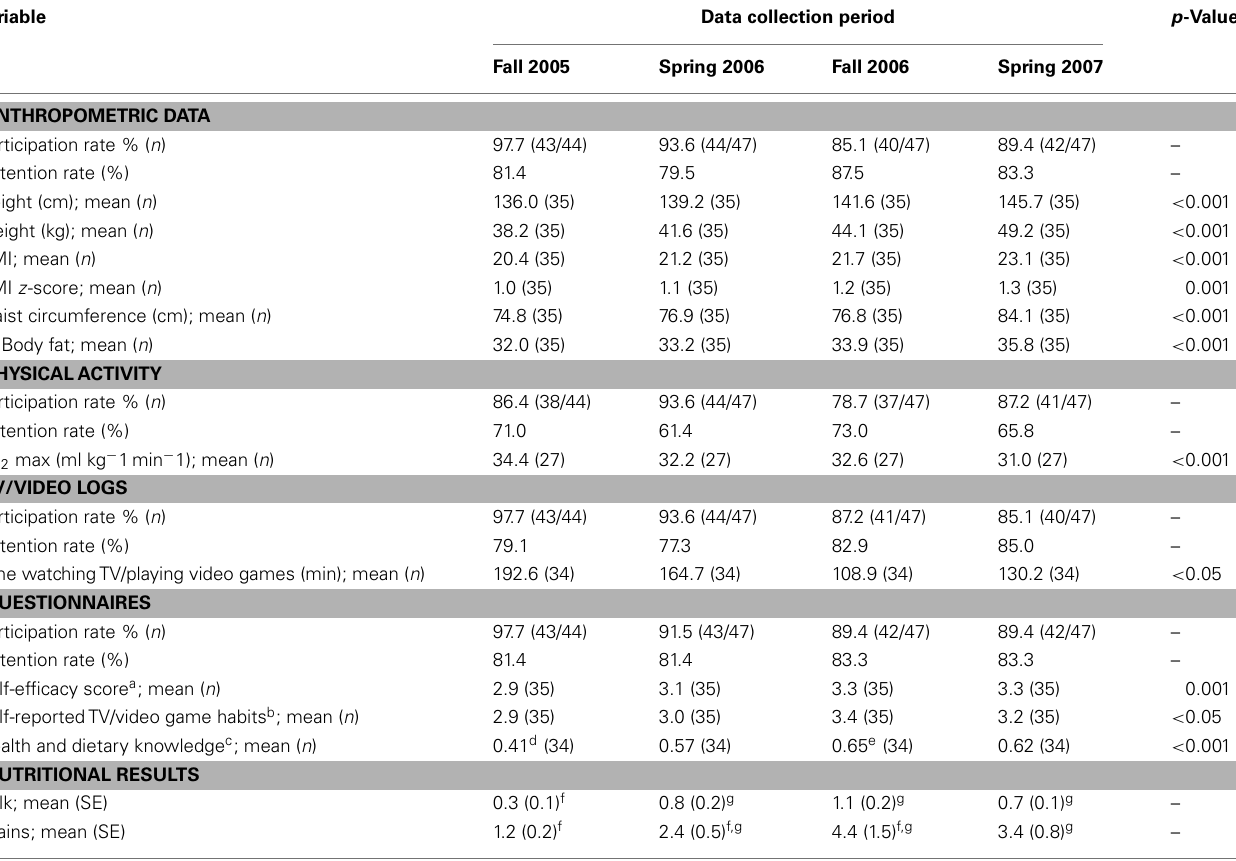
Table 2 | Student demographics, anthropometric, physical activity, questionnaireTV/video game results, and nutritional results (26).